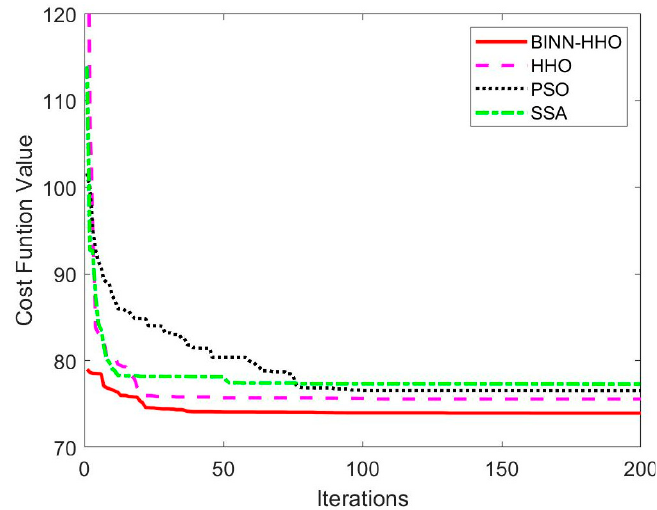
Figure 6. Evolution curves of cost function values in a static environment.